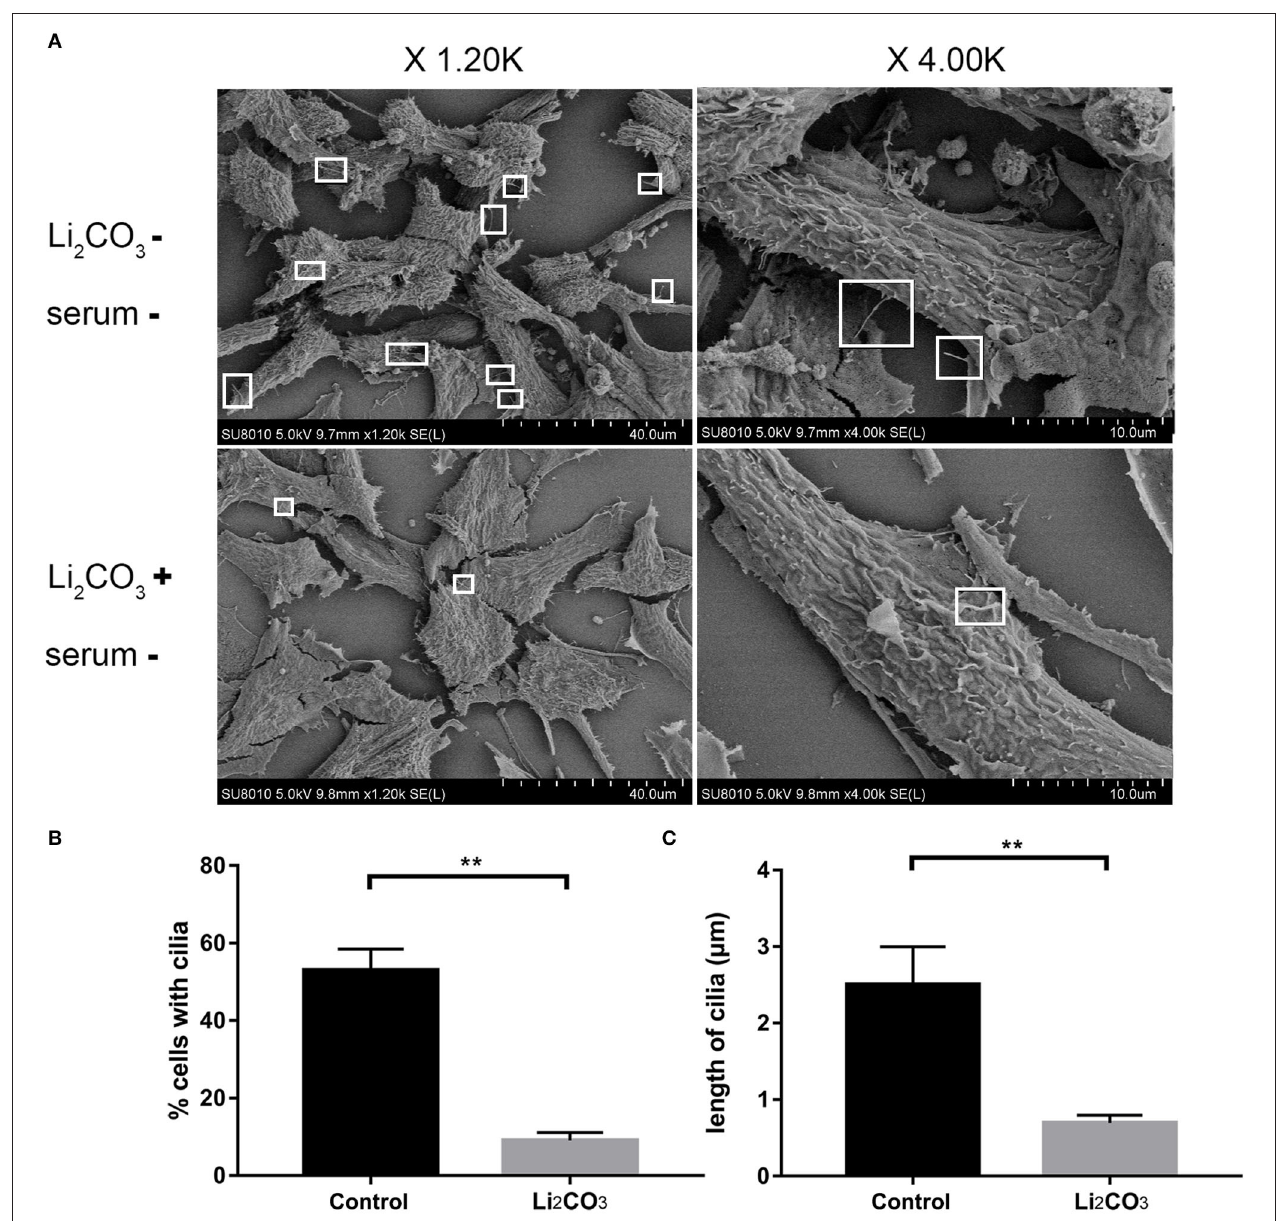
FIGURE 6 | Scanning Electron Microscopy of abnormal cilia in inositol deficiency cell model. (A) Scanning electron microscopy views of primary cilia (white boxes) protruding from NIH3T3 cells treated with ( n = 3) or without 2mM Li 2 CO 3 ( n = 3). (B) Analysis of the percentage of cells with cilia. A total of > 100 cells were analyzed per replicate (four replicates). ** P < 0.01 vs. controls. (C) Quantification of cilia length in NIH3T3 cells. Error bars represent standard error. A total of > 100 cells were analyzed per replicate (four replicates). ** P < 0.01 vs. control group. Each experiment was carried out in